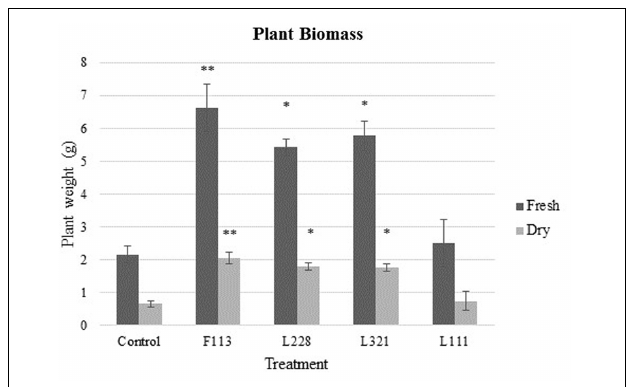
FIGURE 2 | Biomass analysis of B. napus in a greenhouse experiment following inoculation by PGP Pseudomonas and a bacterial consortium after 24 weeks. Data display above ground (shoots/leaves) plant biomass after 24 weeks colonization with the bacterial strains L111, F113, L321, and L228. Bars represent average value for each data series ( n = 3). Error bars represent standard error ( ± SE). ∗∗ P < 0.01; ∗ P < 0.05.